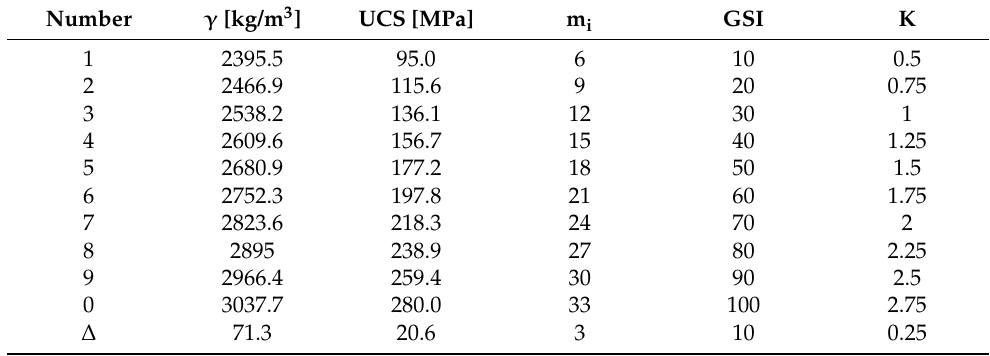
Table 1. Selected values for the five